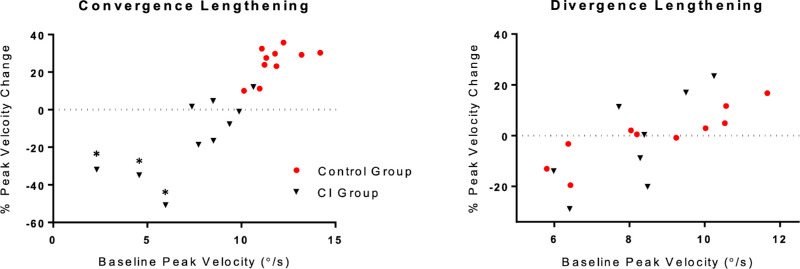
Scatterplots of the mean normalized percent peak velocity change after adaptation compared to the baseline mean for each participant. Asterisks in the left panel are placed above the CI participants’ data where large reductions in peak velocity were observed after adaptive lengthening of their convergence responses.